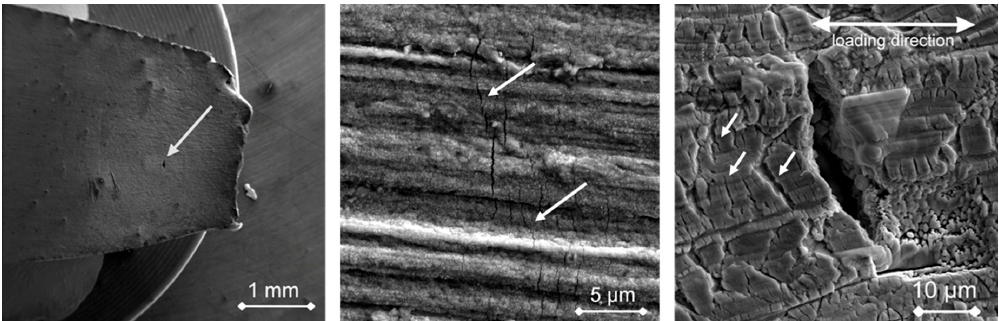
Figure 2. The flat tapered specimen T1 after the CERT test up to rupture, the position of the LME crack in the region of plastic deformation is indicated by arrow ( left ). Slip band cracks are indicated by arrows ( middle ). Detail of the morphology of the large open surface crack selected for further investigation, the crack is oriented ~90° towards the load axis. Note the large number of fine shallow cracks limited to the depth of the oxide layer are indicated by white arrows ( right ).